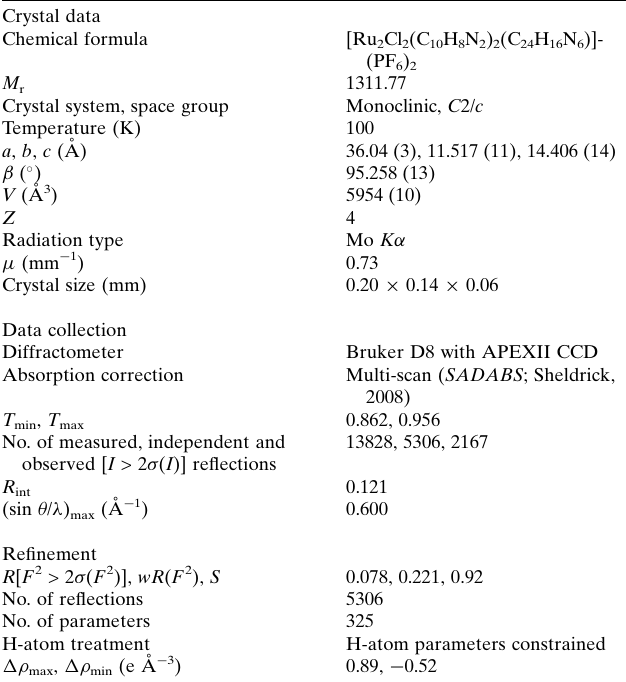
Table 3 Experimental details. Crystal data Chemical